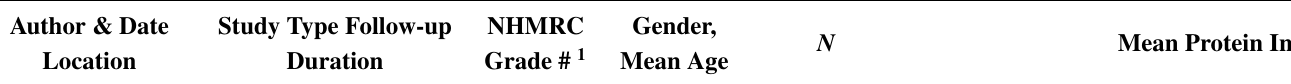
Table 2. Protein intakes and physical function, muscle mass, and